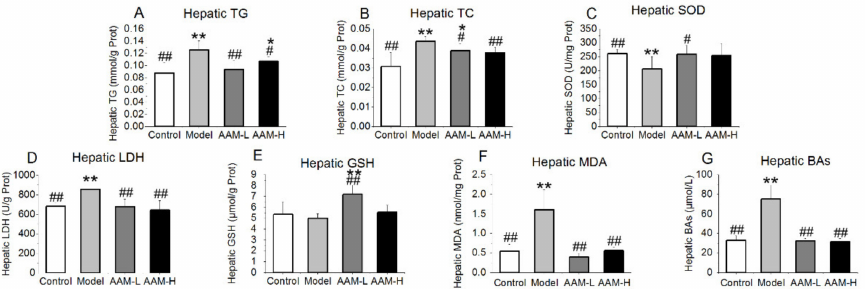
Figure 3. Effects of AAM administration on the liver biochemical profile in mice exposed to alcohol intake for consecutive 6 weeks. ( A ) TG; ( B ) TC; ( C ) SOD; ( D ) LDH; ( E ) GSH; ( F ) MDA; ( G ) BAs. ## p < 0.01 and # p < 0.05, versus the Model group; ** p < 0.01 and * p < 0.05, versus the Control